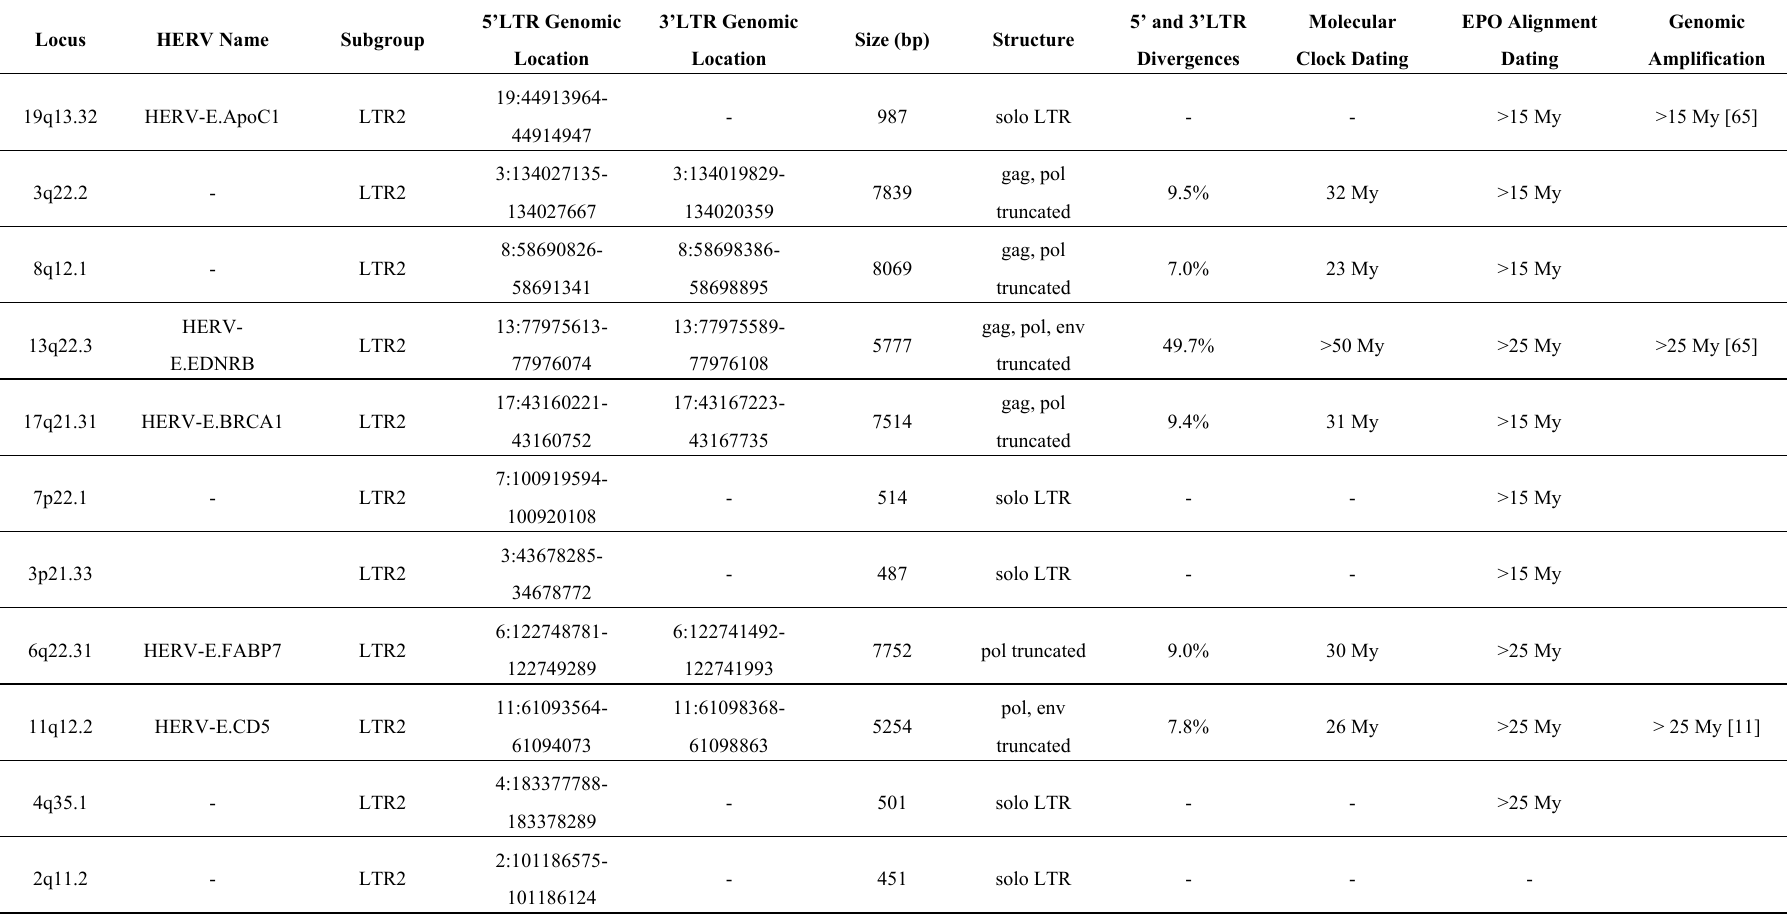
Table 1: Description of the 46 HERV-E elements explored (see Experimental